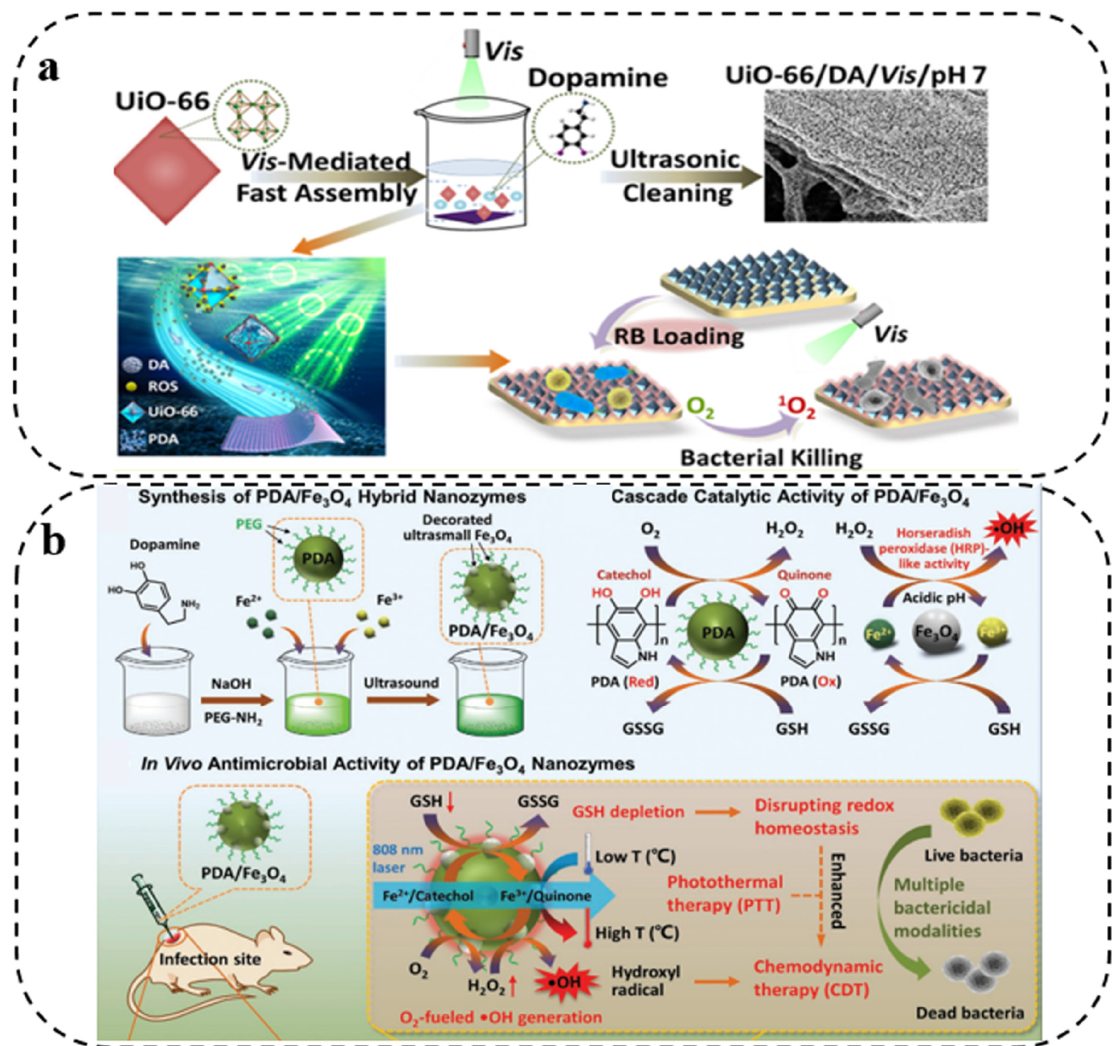
Figure 2. ( a ) Schematic illustration of surface assembling of UiO-66 onto substrates Reprinted with permission from [57] (copyright: American Chemical Society, 2020). ( b ) Schematic representation Synthesis of PDA/Fe 3 O 4 hybrid nanozymes. Reprinted with permission from [59] (copyright: Wiley- VCH, 2022).